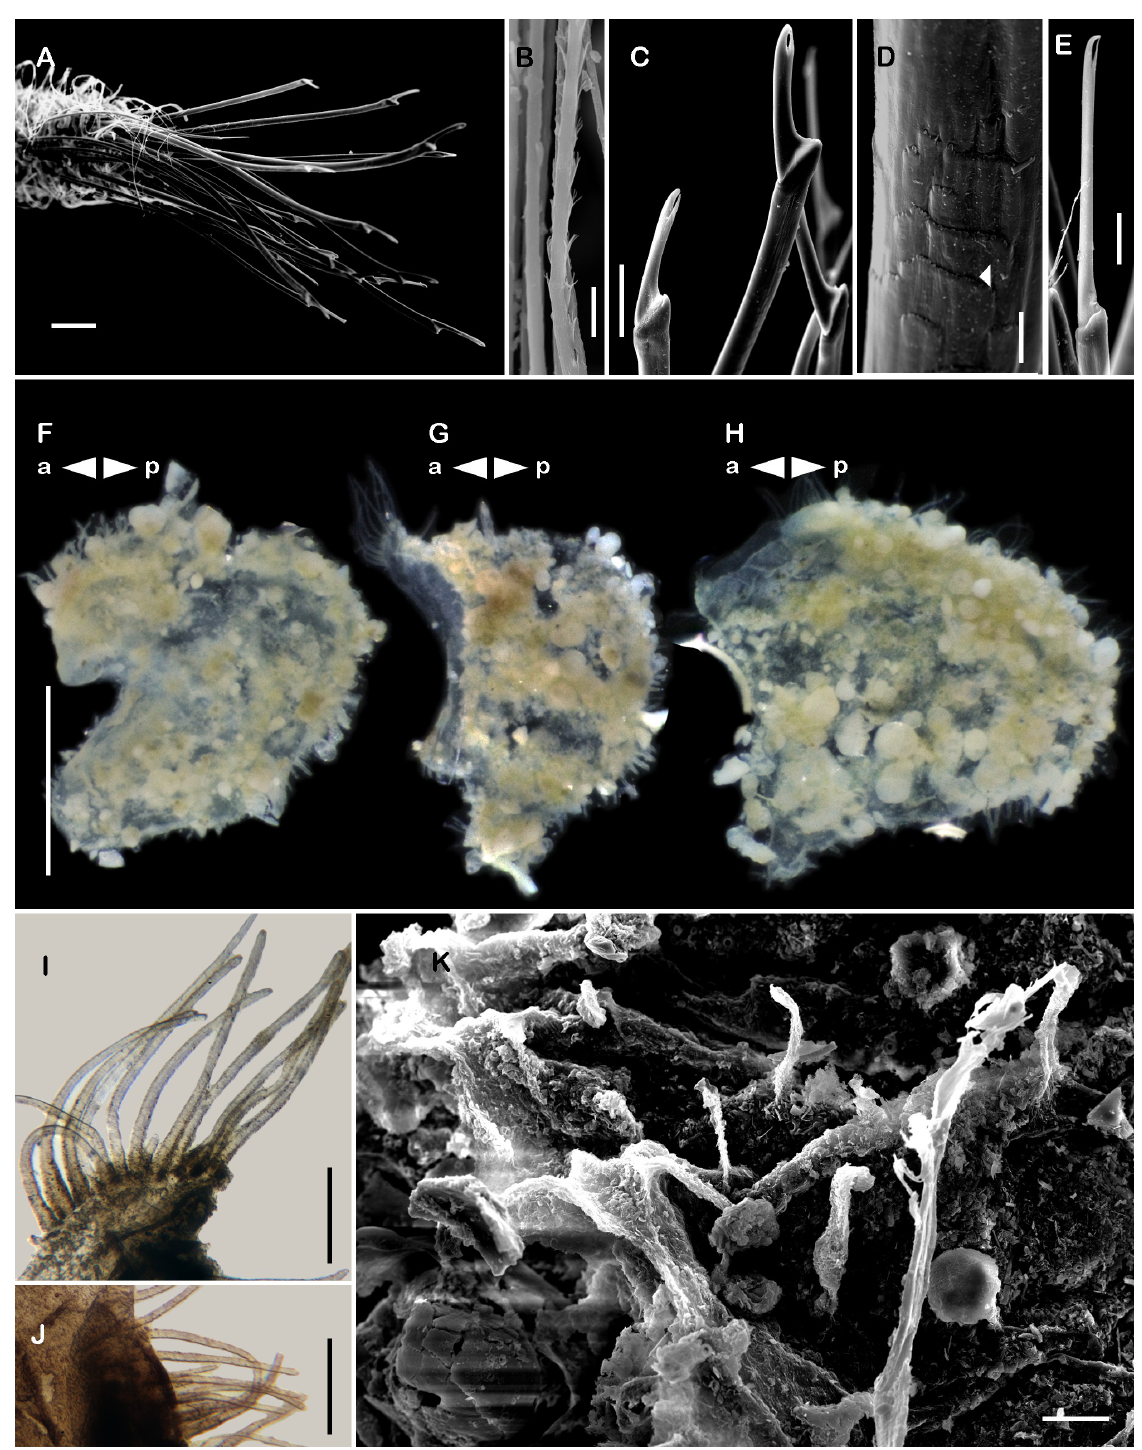
Fig. 10. Neopsammolyce fragilis sp. nov., holotype (UMML 22.1088). A–E, K. SEM micrographs. A . Right parapodium from segment 24. B . Notochaetae from same. C . Units B and C. D . Close-up of unit A, arrowhead indicates subdistal denticle. E . Subunit 1. F . First right elytron. G . Second right elytron. H . Right posterior elytra. I . Detail of margin from G. J . Detail of margin from H. K . Surface of H, flat papillae and pedunculate papillae with flat tips. Abbreviations: a = anterior; p = posterior. Scale bars: A, I–J = 100 μm; B, D = 5 μm; C, E = 50 μm; F–H = 1 mm; K = 20